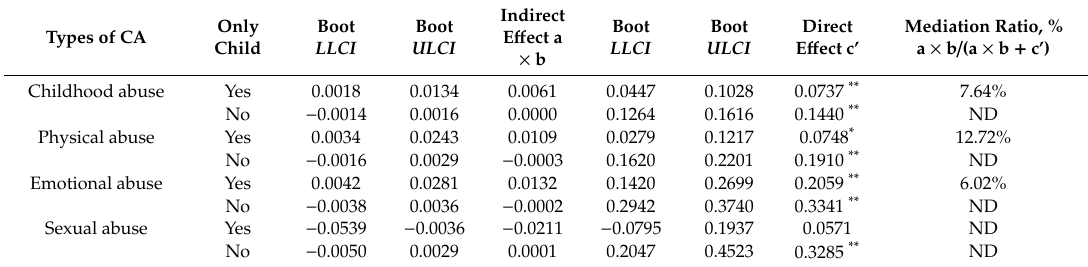
Table A3. Childhood abuse - social support from others -